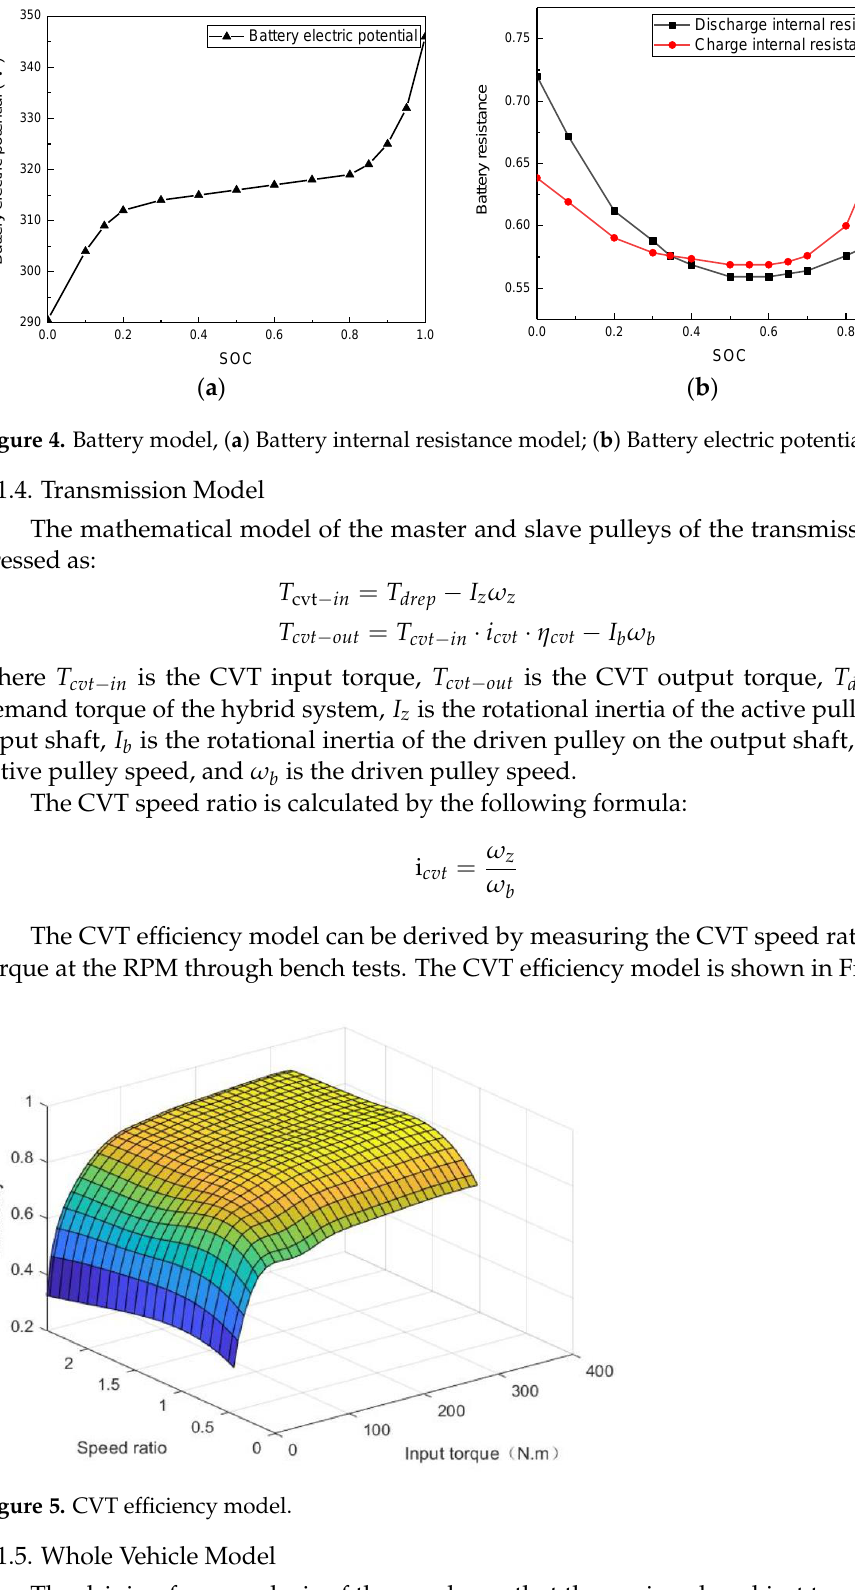
Figure 5. CVT efficiency model.